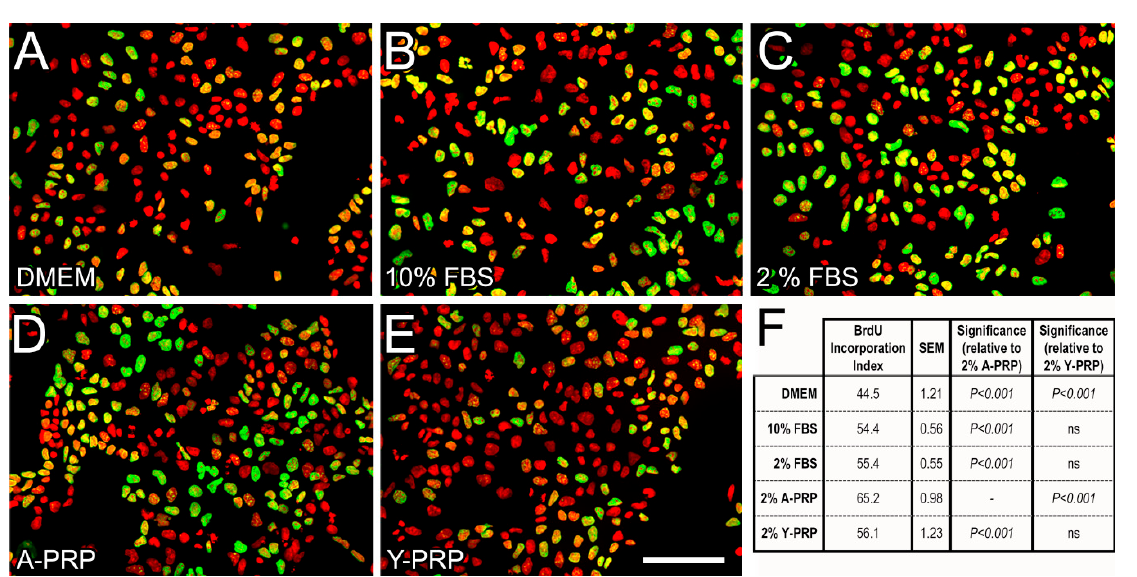
Figure 3. Epifluorescence microscopy images of NT2 cells showing the effect of replacement of FBS by PRP on BrdU incorporation. ( A – E ). Epifluorescence microscopy images of NT2 cells subjected to a 4-h BrdU pulse after growing for 24 h in either serum-free DMEM medium ( A ) or in 10% FBS ( B ), 2% FBS ( C ), 2% Aged-PRP supplemented DMEM ( D ), or 2% Young-PRP supplemented DMEM ( E ). Cells were processed for double immunofluorescence against BrdU (green), combined with Hoechst’s chromatin staining (pseudocolored red). Scale bar: 50 µm ( F ) Table showing results of BrdU incorporation analysis.